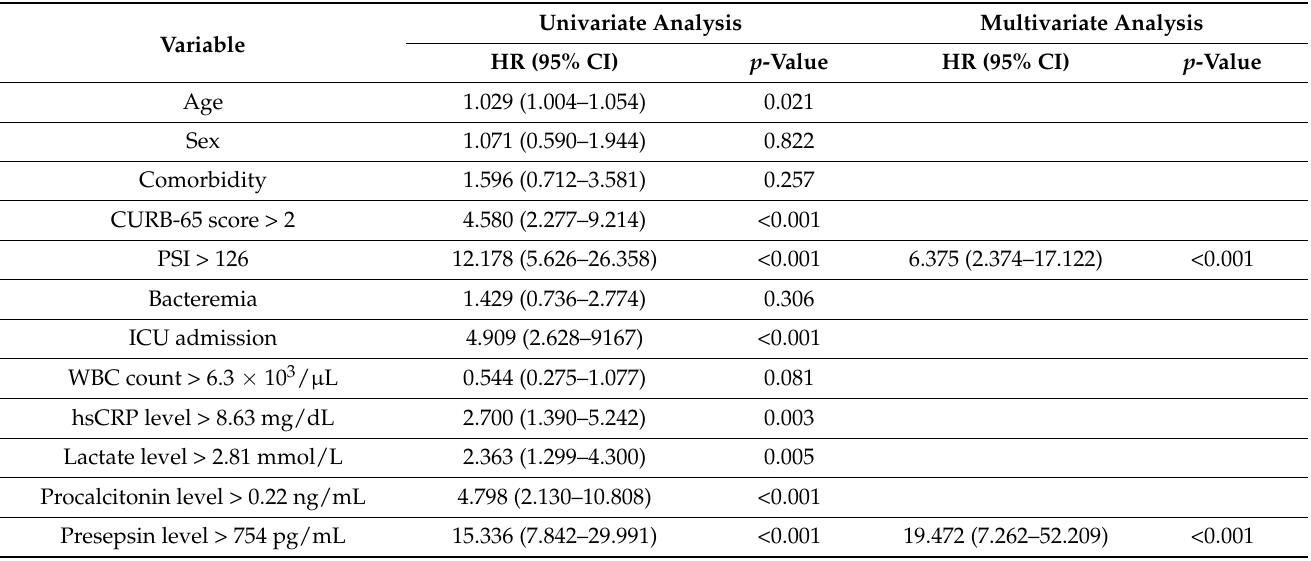
Table 5. Variables associated with 30-day mortality were identified using Cox regression